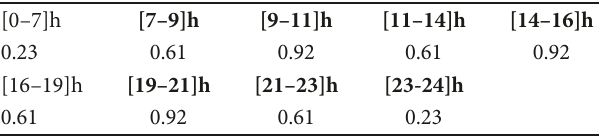
Table 3: Time-of-use electricity prices per day ( unit Yuan/kWh ) [23].